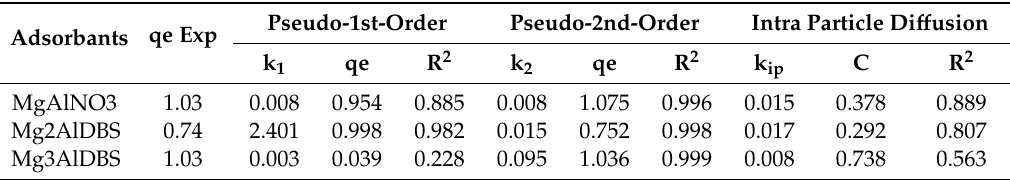
Table 6. Kinetic parameters of pseudo-first-order, pseudo-second-order and intra-particle diffusion models for BG adsorption on MgAlNO3, Mg2AlDBS and Mg3AlDBS.